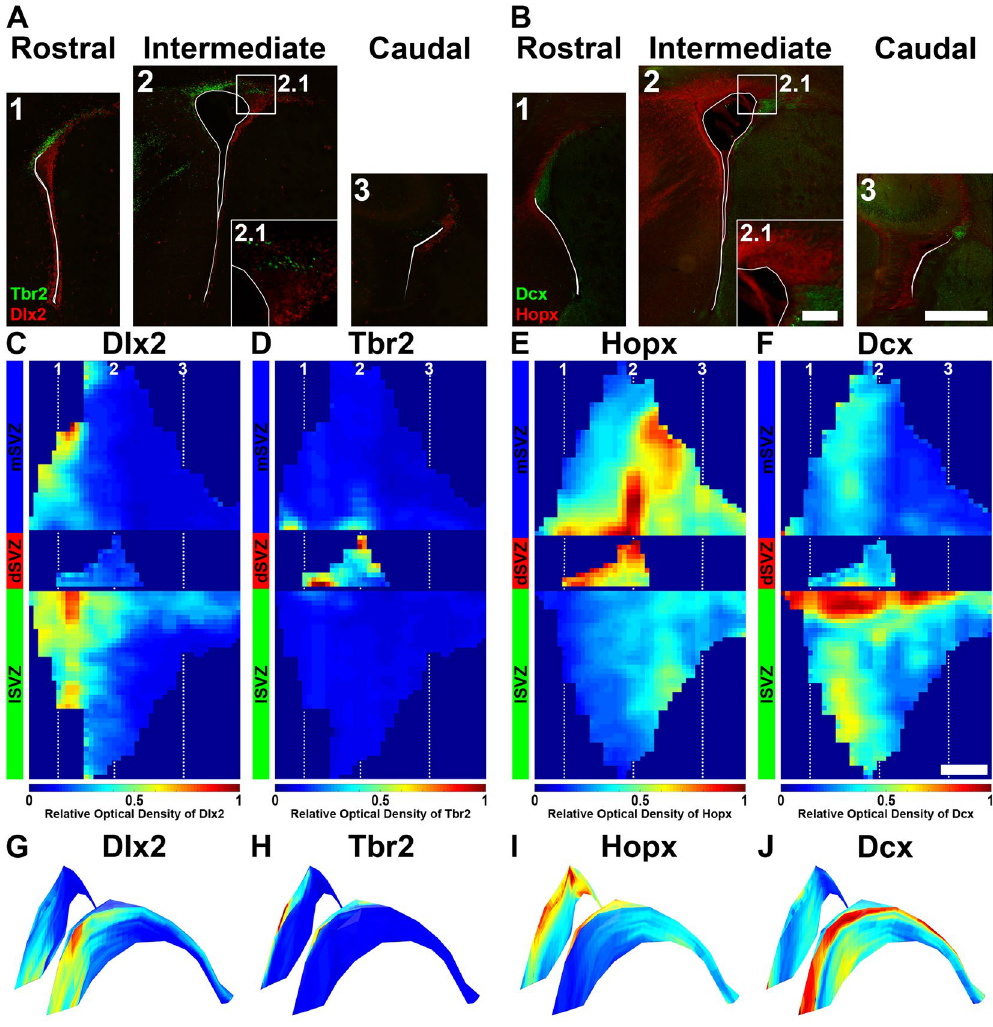
Figure 6. Illustration of “FlashMap” analysis with four regionally expressed markers. (A,B) Representative micrographs of Dlx2, Tbr2 ( A ), Hopx and Dcx ( B ) at rostral (A1,B1), intermediate (A2,B2) and caudal coordinates (A3,B3) along the rostro-caudal axis of the ventricular system. (C–F) 2D expression heatmaps obtained for Dlx2 ( C ), Tbr2 ( D ), Hopx ( E ) and Dcx ( F ) along the full extent of the SVZ are represented in a colour code of relative OD. (G–J) 2D heatmaps of Dlx2 ( G ), Tbr2 (H), Hopx ( I ) and Dcx ( J ) are superimposed in 3D LVs. Scale bars: (B2.1) = 100 µ m; (B3,F) = 500 µ m. Abbreviations: 2D, two-dimensional; 3D, three- dimensional; lSVZ, lateral subventricular zone; dSVZ, dorsal subventricular zone; mSVZ, medial subventricular